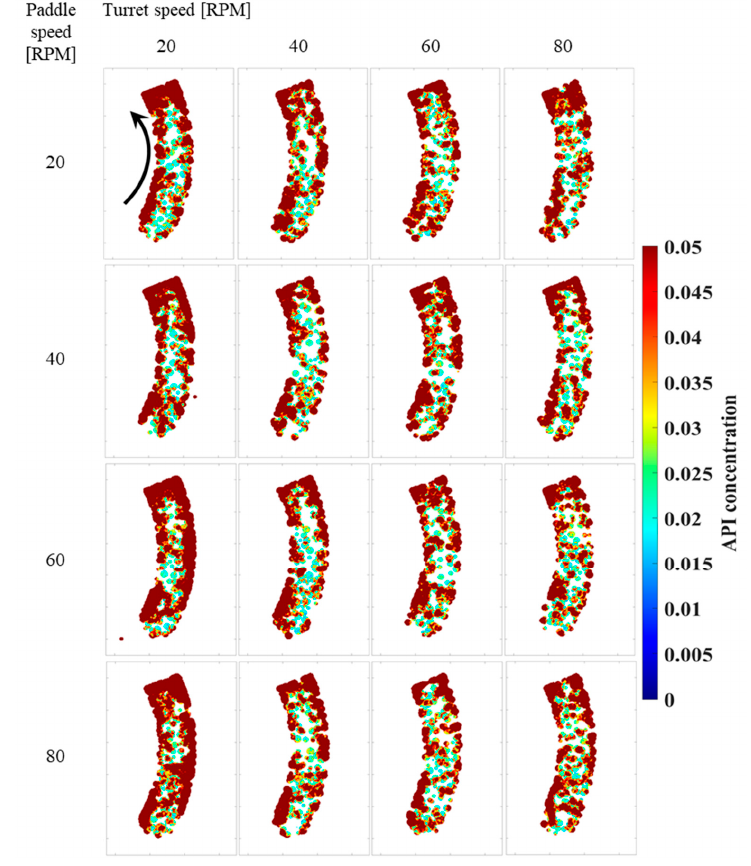
Figure 15. Top view of the API particle concentration distribution in the seal opening at different paddle and turret speeds, where each column corresponds to a different turret speed and each row corresponds to a different paddle speed. The arrow in the upper left corner indicates the direction of rotation of the turret.